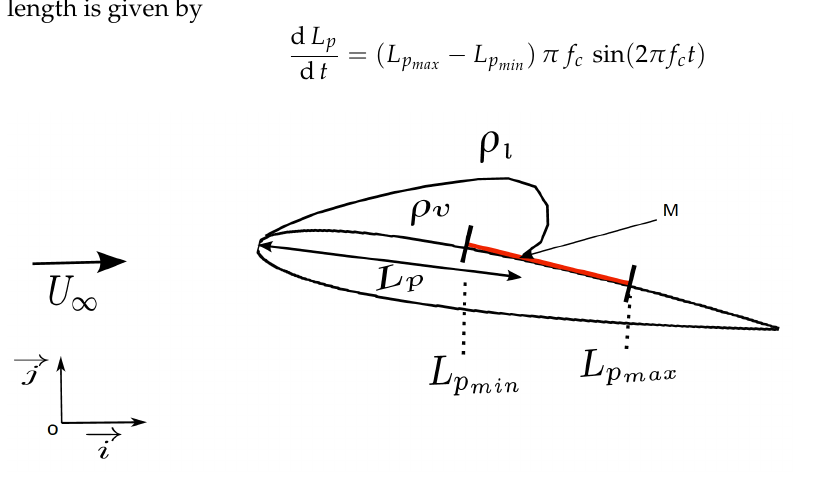
Figure 3. Modeling of sheet cavitation. M oscillation belongs to [ L p